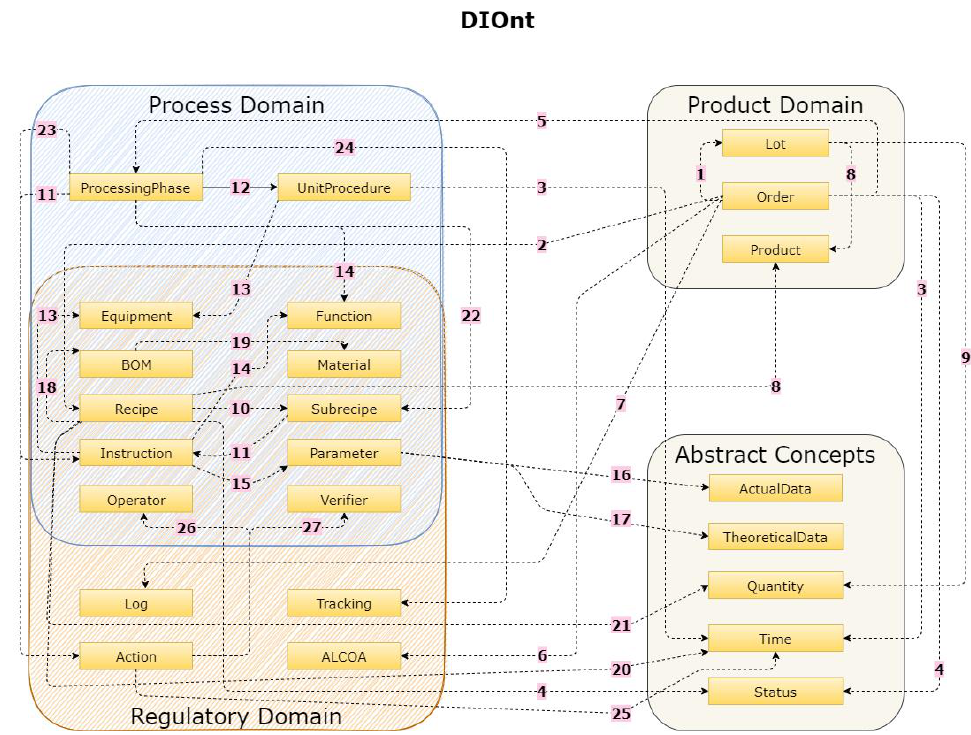
Figure 3. DIOnt inter-domain entity relationships. Table 1. DIOnt object